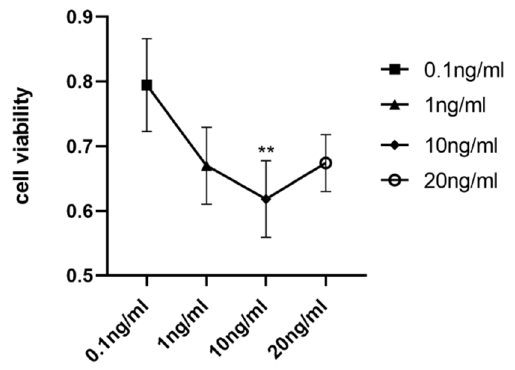
Figure 7. Cell viability of chondrocyte stimulated with IL-1 β at different concentrations: comparison between 0.1 ng/mL and 10 ng/mL. (** p < 0.01).